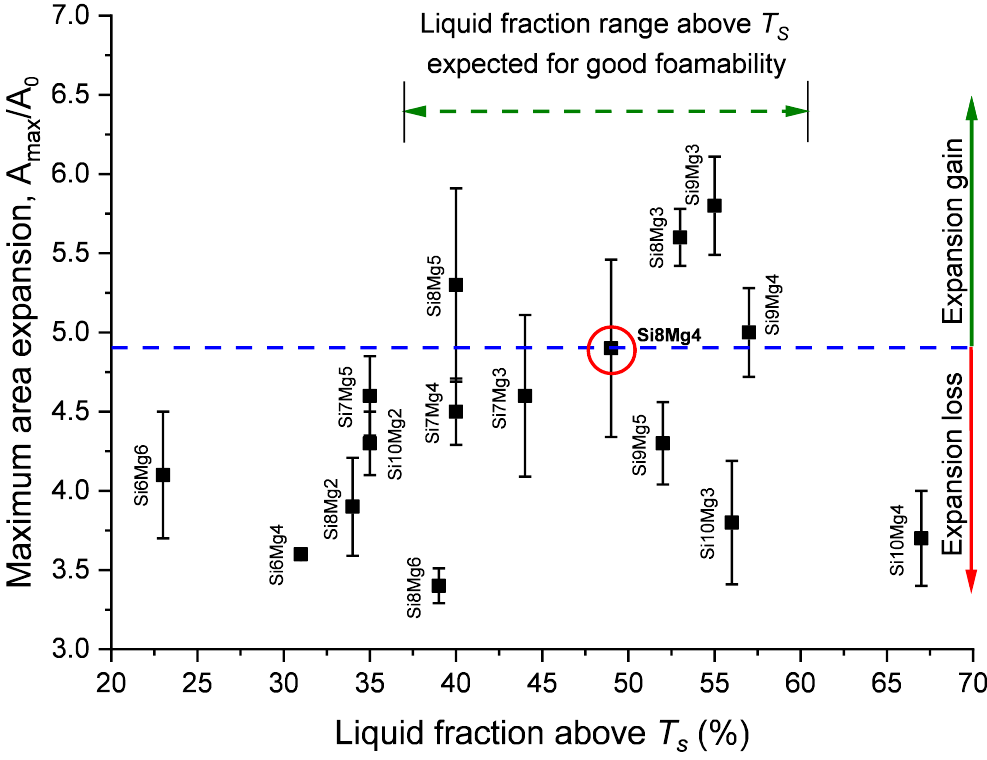
Figure 10. Maximum area expansion versus theoretical liquid fraction at the solidus temperature T S = 558 °C, displaying the expansion gain or loss found for different alloy compositions with respect to the reference system AlSi8Mg4. The range of expected good foamability is marked in green.